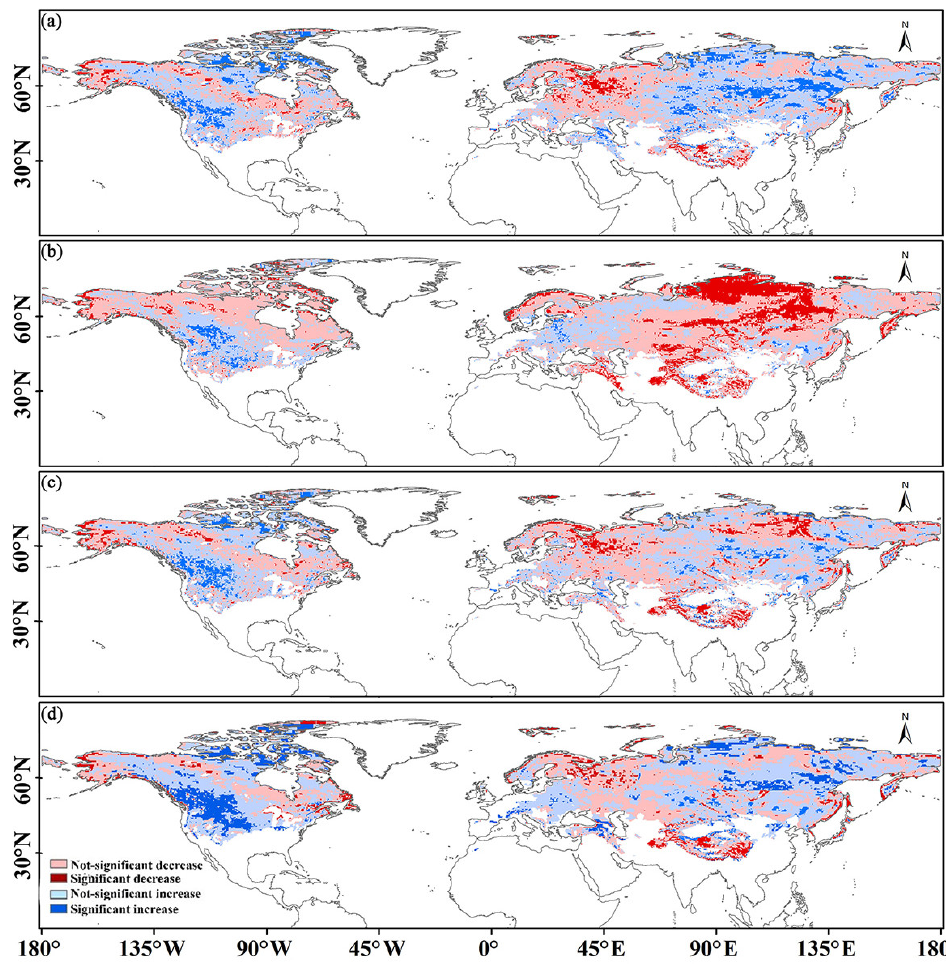
Figure 8. Significance patterns ( p < 0.05) in the annual ( a ) SCOD, ( b ) SCED, ( c ) SSL, and ( d ) SCD. Significance was assessed at the 5% level.